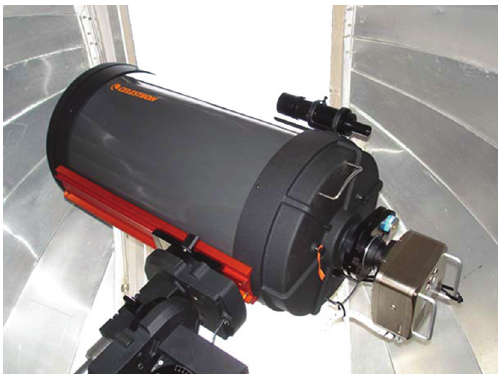
Figure 1: Dome of the T35 telescope. Figure 2: The telescope and CCD Camera.